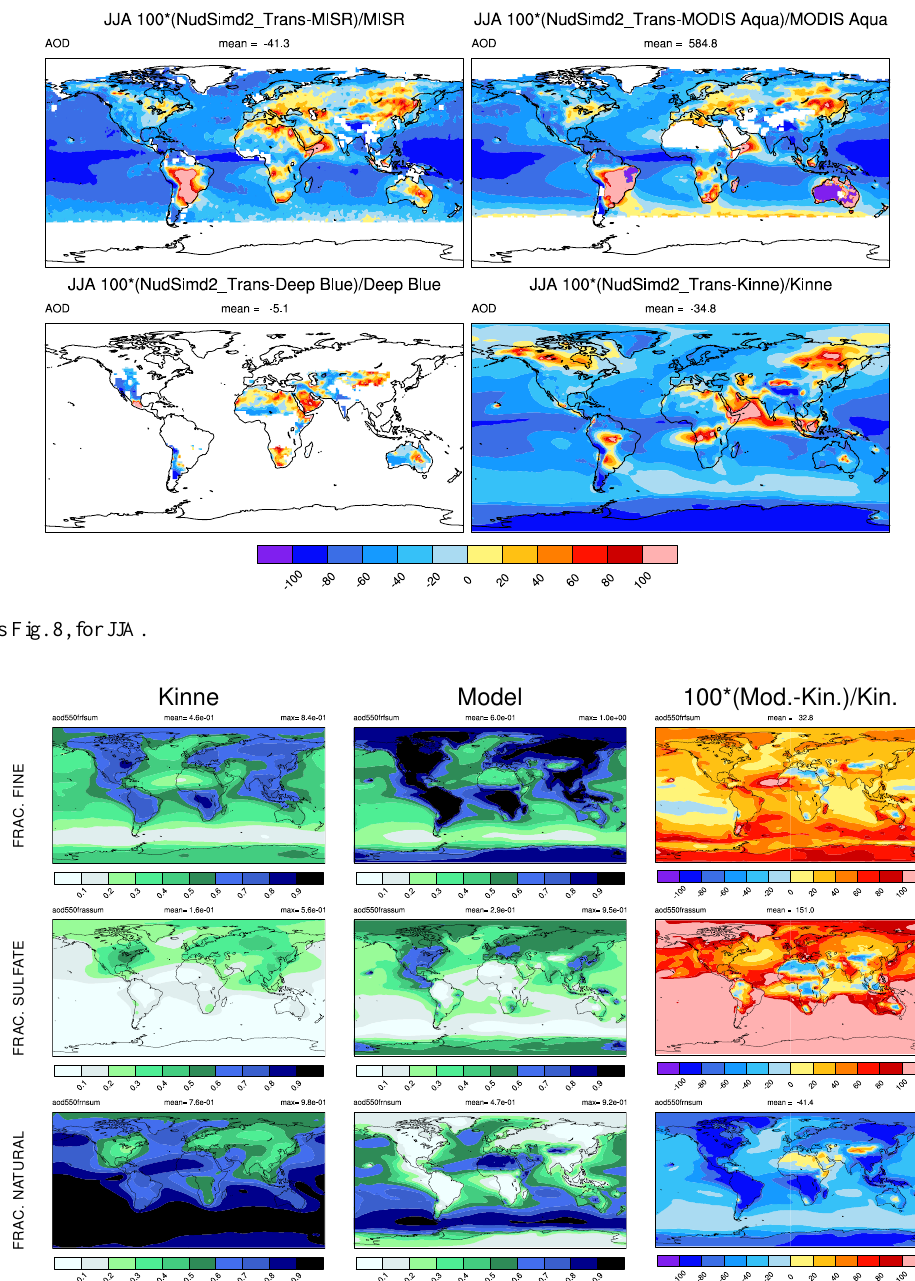
Figure 10. Mean annual fractional AOD from the Kinne et al. (2013) climatology (first column), NudSimd2_Trans simulation (1996–2005) (second column) and relative difference between the two data sets: fractions of fine-mode (first row), of sulfate (second row), and of natural aerosols (third row) (see text for details).